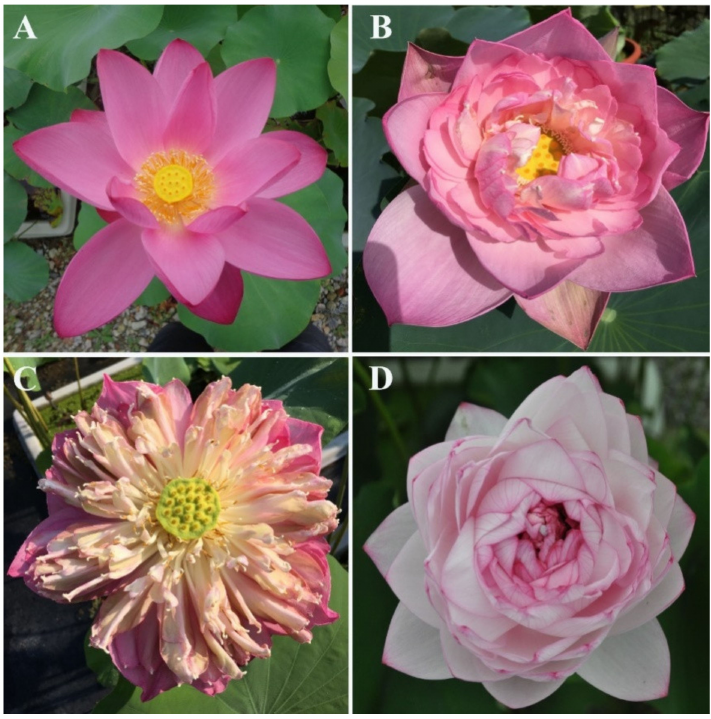
Figure 1. The floral forms of Nelumbo nucifera . ( A ) Single form; ( B ) semi-double form; ( C ) double form; ( D ) thousand-petalled